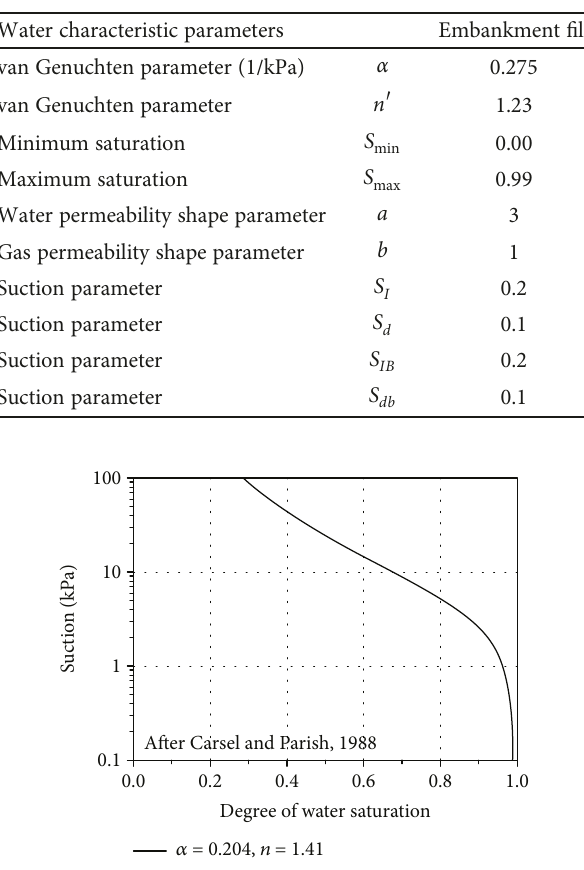
Figure 14: Soil-water characteristic curve used for Naruse soil.